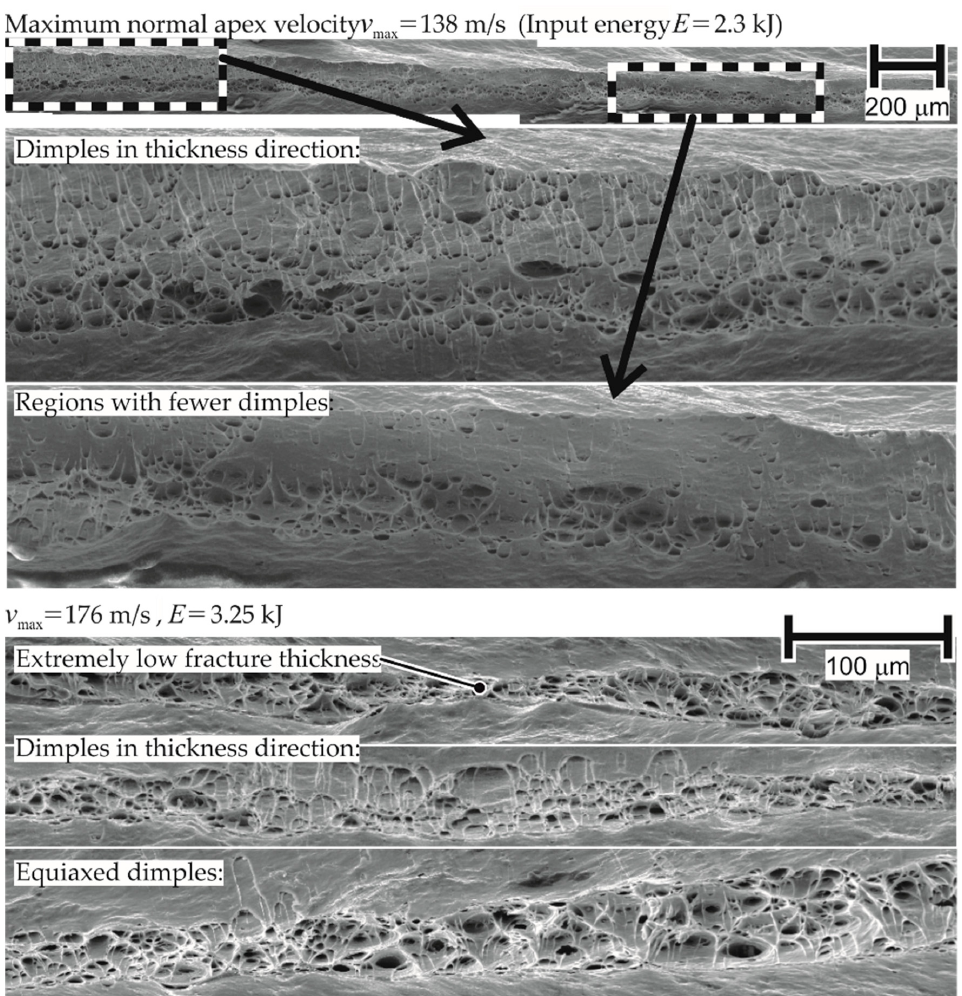
Figure 24. Fracture of electromagnetically formed 1 mm thick AA-1050a-H24 under uniaxial tension. On observation of the fracture surface of AW-5083-H111 in Figure 25, certain regions without dimples are noticed. Based on the reasoning used for inferring that the failure for AA-1050a-H24 is ductile at high strain rates, the absence of dimples implies a change in the failure mechanism to brittle for AW- 5083-H111. However, the current work considers an alternative explanation as well: such surfaces may result from the rubbing of mating fracture surfaces at high temperatures, which is also seen in the research of Shih-Chieh and Duffy [30]. While the fracture surface provides useful information about the forces during the process, it cannot be explicitly stated that the change in failure mechanism is the reason for the difference in material properties at higher strain rates when compared to quasi-static tests.